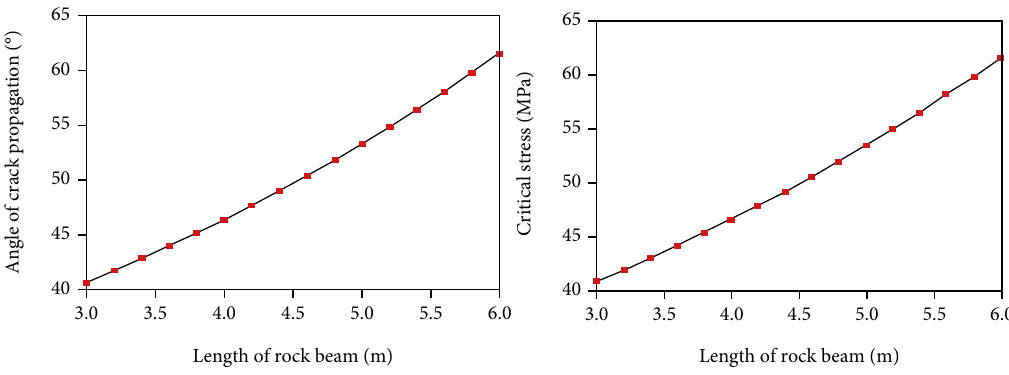
Figure 11: Analysis of crack propagation angle and critical stress and length of rock beam.